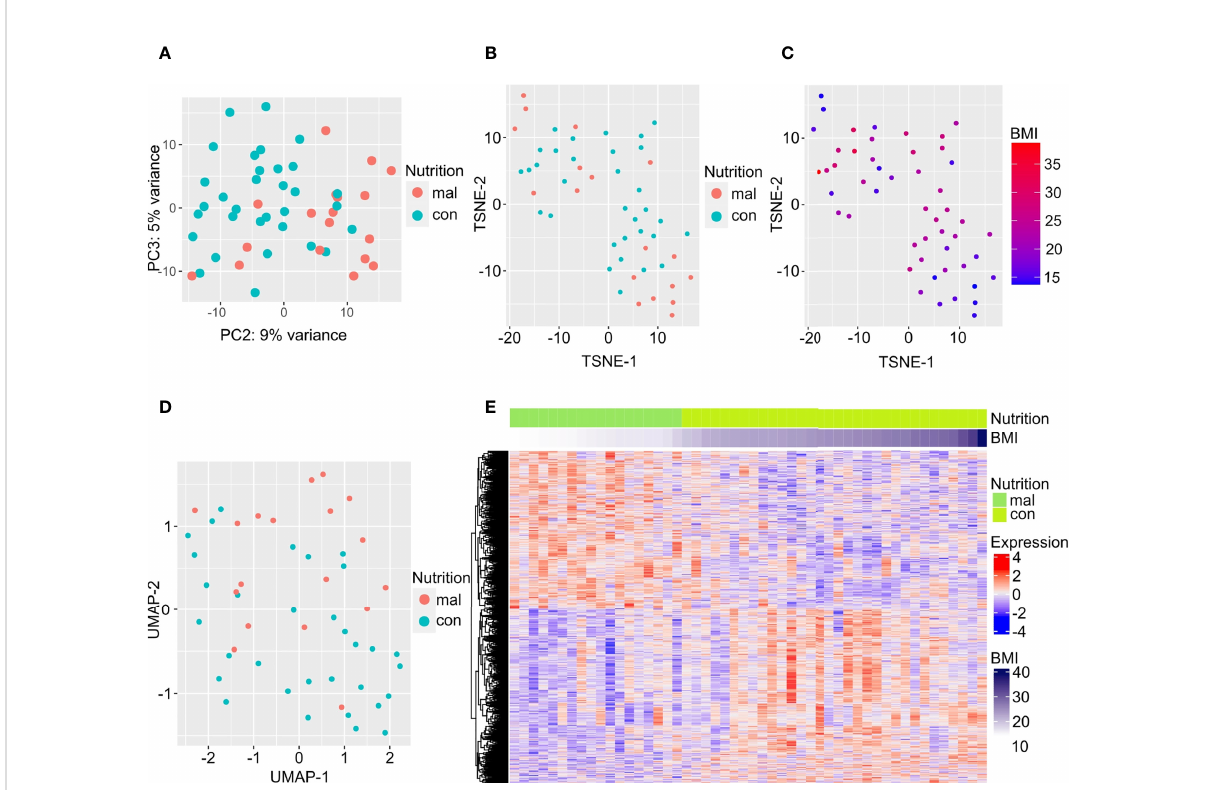
FIGURE 1 Differentially expressed genes separate individuals with LTBI who are malnourished from controls. Dimension reduction by PCA (A) , tSNE (B, C) , and UMAP (D) of RNA-sequencing data are plotted here, with the points in C colored by BMI. The top 500 DEGs (by least adjusted p-value) are depicted in the heatmap; columns are organized by BMI of individuals with LTBI from lowest to highest (E)